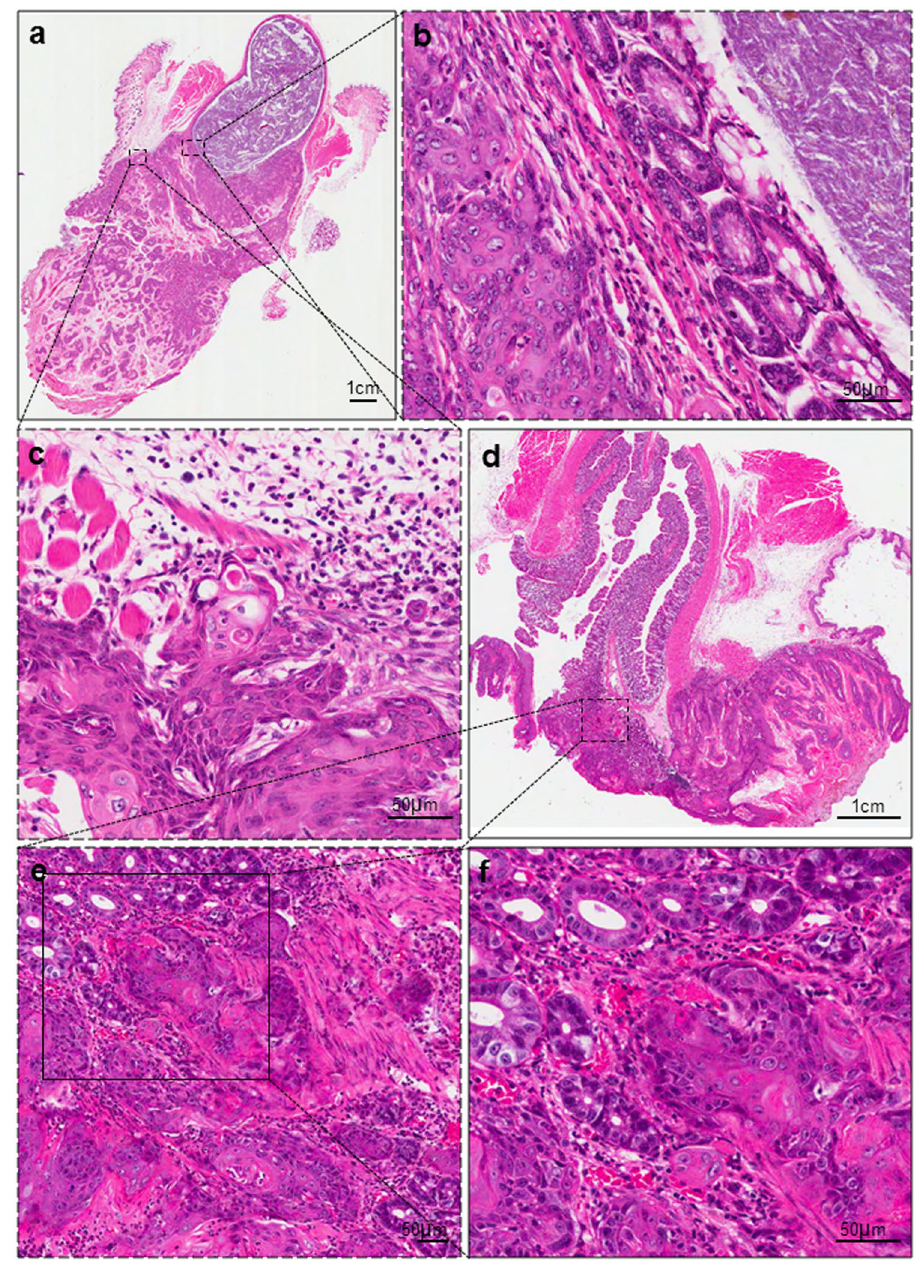
Figure 1. Histological views of ASCC in Tgfbr1/Pten 2cKO mice. ( a ) A representative sagittal section of mice ASCC. Scale bar = 1 cm ( b , c ) High-power fields of the tumor margins. Tumor islands were extended into underlying tissue with well-defined invasive front and accompanied by stromal reaction. Distinct nuclear pleomorphism was seen. Scale bar = 50 μ m. ( d ) Another representative sagittal section of mice ASCC. Scale bar = 1 cm ( e , f ) High-power fields of the tumors showing tumor cords invaded into the muscle layer. Nebulous infiltrating margins and discontinuous basal layers were seen. Cancer cells were forming irregular small strands or cords with poor keratinization. Densely infiltrating lymphocytes were seen. Scale bar = 50 μ